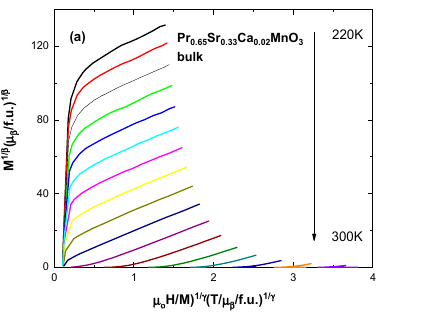
are presented in this work. Alternatively, all critical exponents for nano-sized particles fall within the mean field model values ( β = 0.541, γ = 1.01, δ = 2.867 for x = 0.02) which is comparable to reported values in La 0.7 Ba 0.3 − x Ca x MnO 3 compounds [22]. Similarly, to the bulk, critical values for nano-sized sample x = 0.3 are not presented.